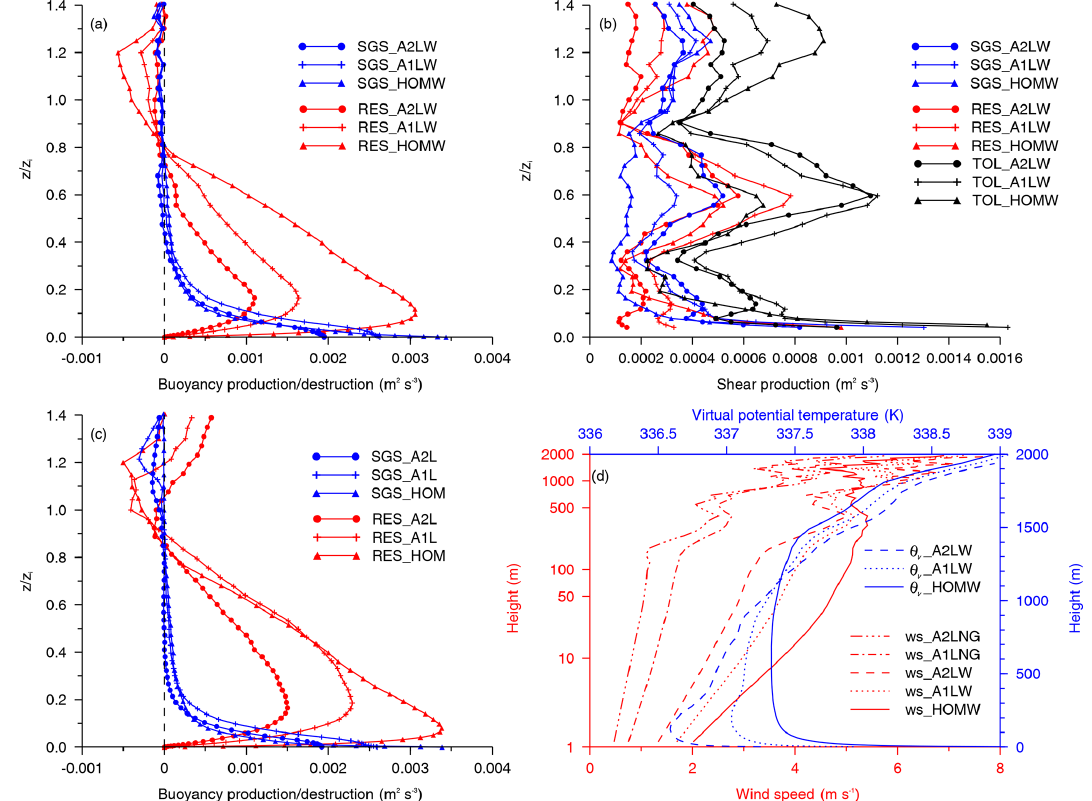
Figure 7. Vertical profiles of the buoyancy flux (a) and the shear production term (b) for runs HOMW, A1LW, and A2LW with background wind, and the profiles of the buoyancy flux (c) for runs HOM, A1L, and A2L without background wind. (d) The simulated mean wind versus logarithm of height for runs HOMW, A1LW, A2LW, A1LNG and A2LNG, and the virtual potential temperature profiles (blue line) at the same time (15:30LT). The resolved and subgrid results are presented as red and blue lines, respectively. The black lines in (b) are the total (resolved and subgrid scale) shear production